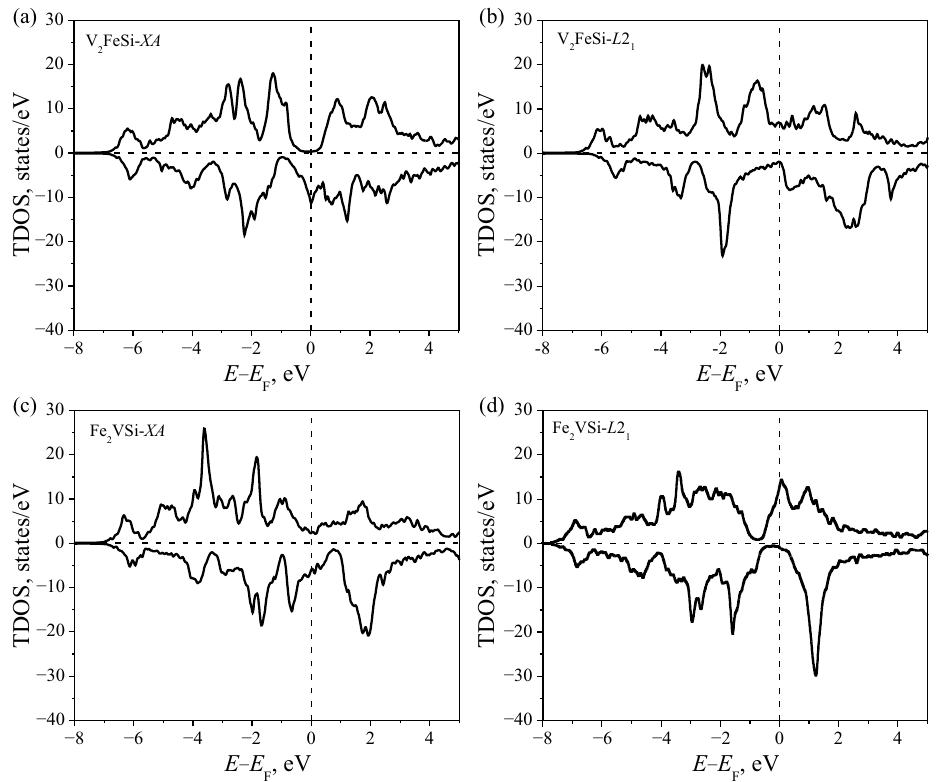
Figure 2. Calculated total density of states for V 2 FeSi in ( a ) XA and ( b ) L 2 1 structures, and for Fe 2 VSi in ( c ) XA and ( d ) L 2 1